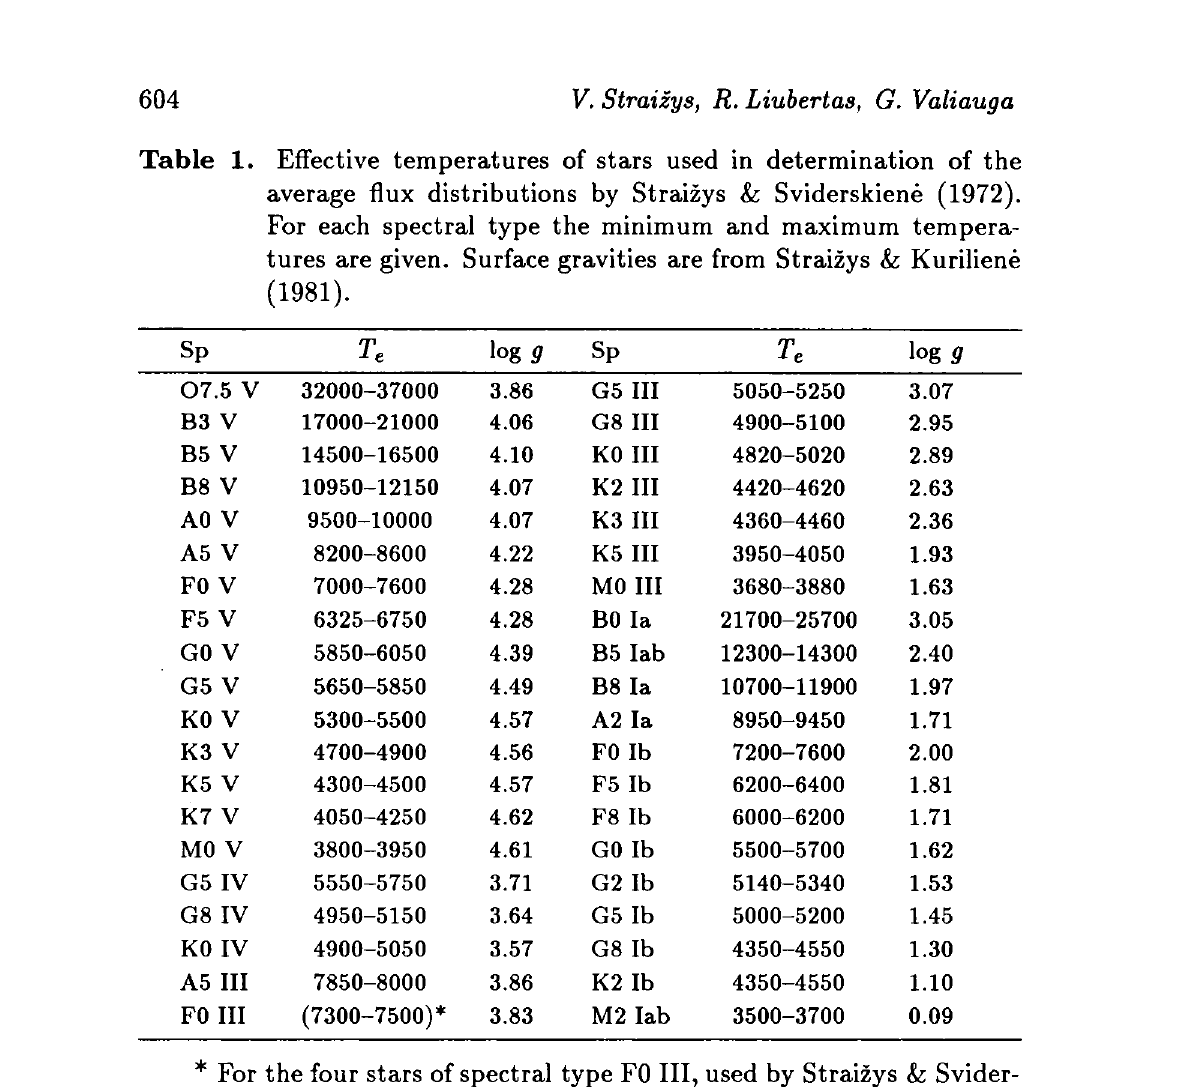
Table 1. Effective temperatures of stars used in determination of the average flux distributions by Straizys & Sviderskiene (1972). For each spectral type the minimum and maximum tempera- tures are given. Surface gravities are from Straizys & Kuriliene